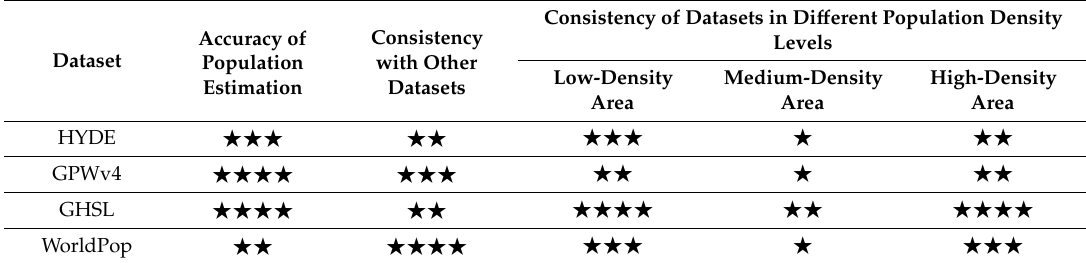
Table 8. Applicability of datasets in di ff erent population density